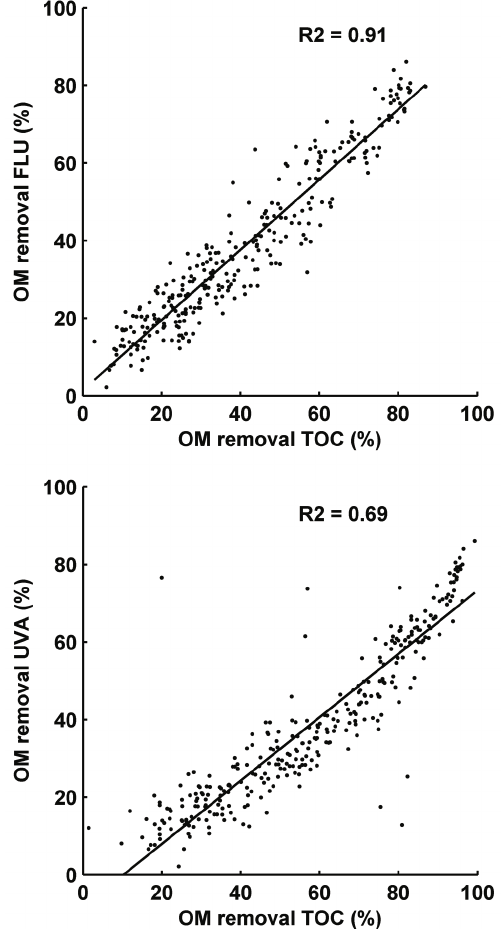
Figure 4. OM removal prediction with di ff erential fluorescence (OM removal FLU) and di ff erential UVA (OM removal UVA) be- tween raw and clarified